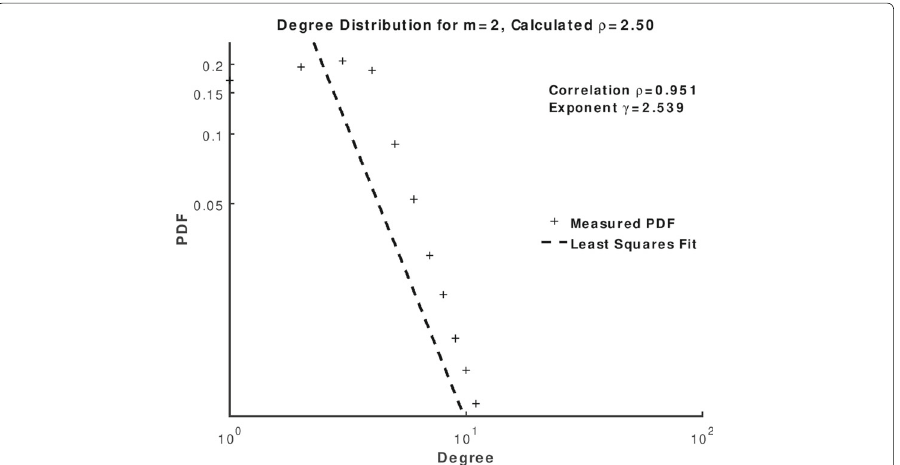
Fig. 5 Probability Distribution Function (PDF) plotted on a logarithmic scale. The network was generated using Eq. (2) for a network arrested at t = 2500, and valency parameter m = 2 The power law exponent is measured as γ = 2.539, and is linear on a least squares fit with correlation coefficient ρ =